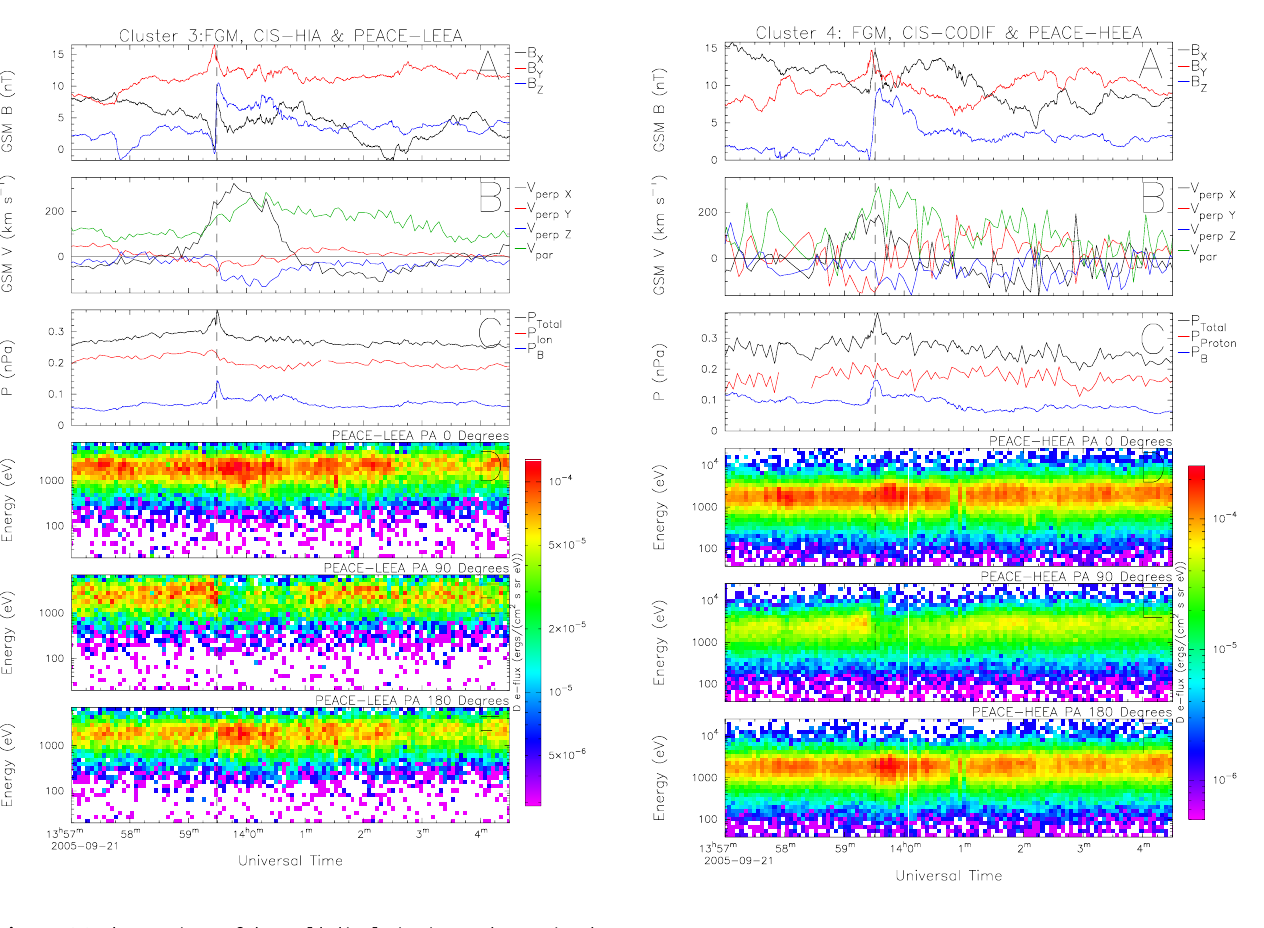
Fig. 8. C4 observations of the field dipolarisation and associated plasma features. Panel (A) shows GSM B X (black), B Y (red) and B Z (blue) from FGM, panel (B) GSM V ⊥ X (black), V ⊥ Y (red), V ⊥ Z (blue) and V // (green) for ions from CIS-CODIF, panel (C) to- tal (i.e. magnetic + ion) pressure (black), ion pressure (red) and magnetic pressure (blue) and panels (D–F) energy time spectro- grams from PEACE-HEEA for pitch angles of 0 ◦ , 90 ◦ and 180 ◦ , respectively. The vertical dashed line marks the entry of the space- craft into the region of